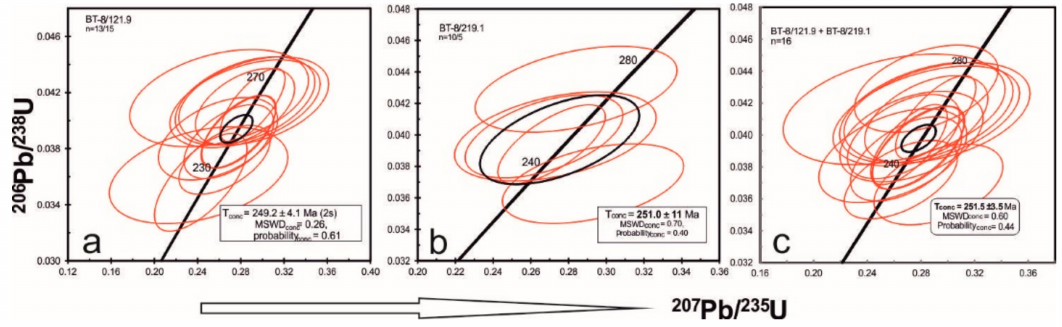
Figure 13. The U–Pb diagrams with concordia for baddeleyite from the gabbro-dolerites of samples BT-8 / 121.9 ( a ) and BT-8 / 219.1 ( b ), and summary for 16 concordant data-points from these samples ( c ) Reported ellipses correspond to a 95% level of confidence of analytical